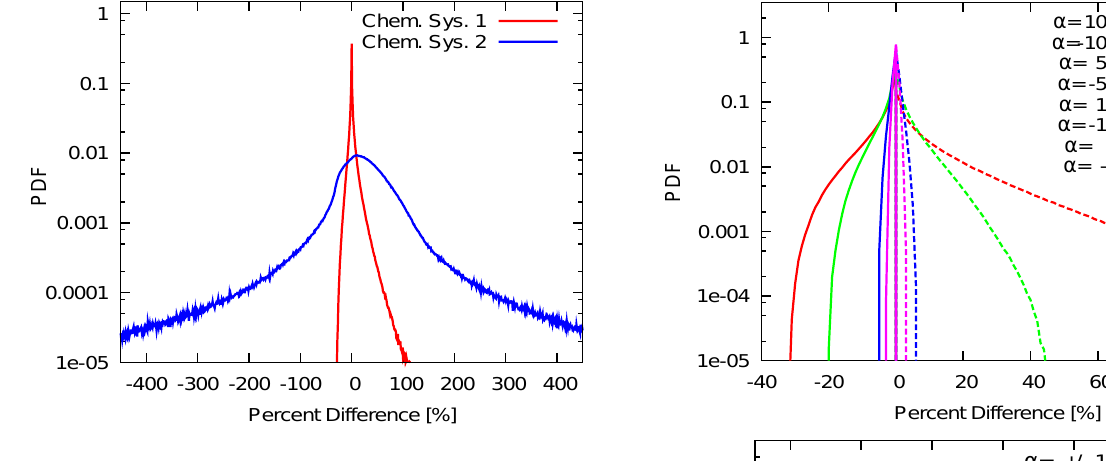
Fig. 5. Probability density function for the errors of the contribu- Fig.5. Probabilitydensityfunctionfortheerrorsofthecontribution tion calculation based in the sensitivity method: error E (red) and calculation based in the sensitivity method: error E (red) and ˜ E ˜ E (blue) [%], i.e. for the first and second chemical system. A range (blue) [%], i.e. for the first and second chemical system. A range of values for X , Y , X i , Y i , and α is taken into account with a Monte- of values for X , Y , X i , Y i , and α is taken into account with a Monte- Carlo Simulation. See text for details. Carlo Simulation. See text for details.